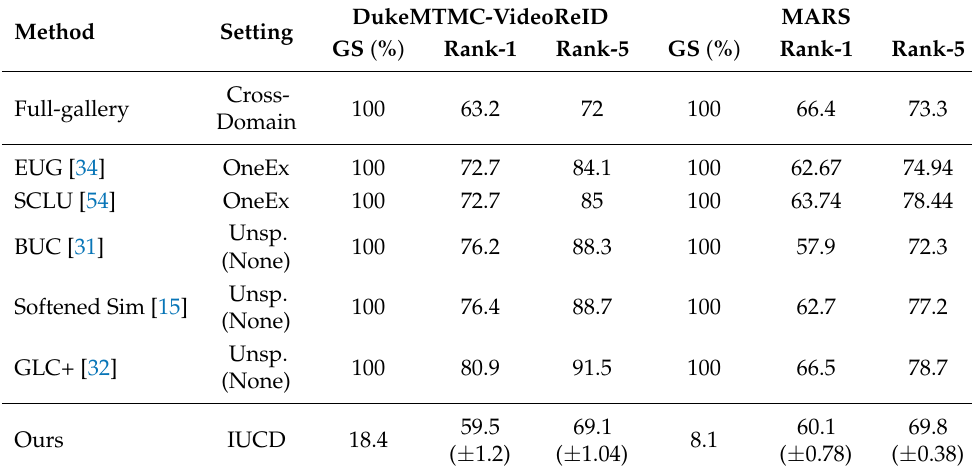
Table 2. Comparison with re-id approaches in DukeMTMC-VideoReID and MARS query set